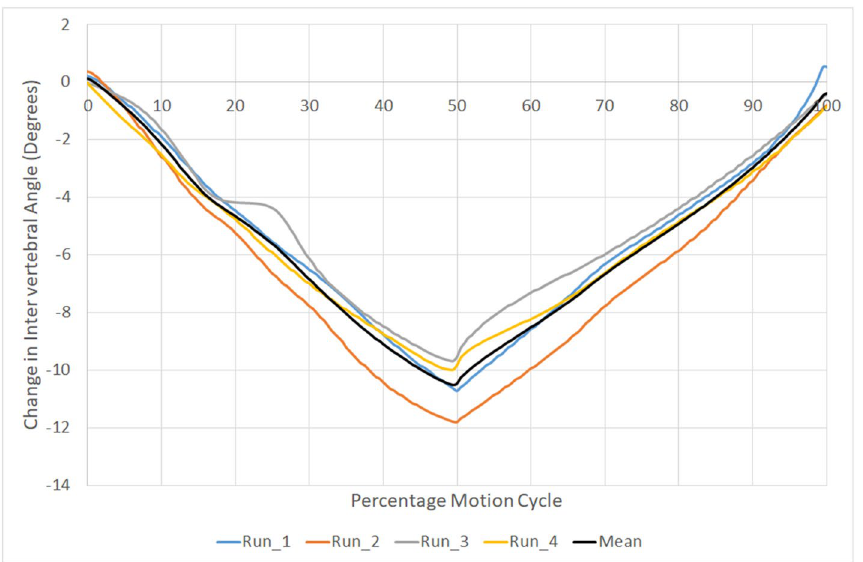
Figure 2. Example of repeated motion paths of C3–C4 for one participant normalised to percentage of the C2– C6 motion